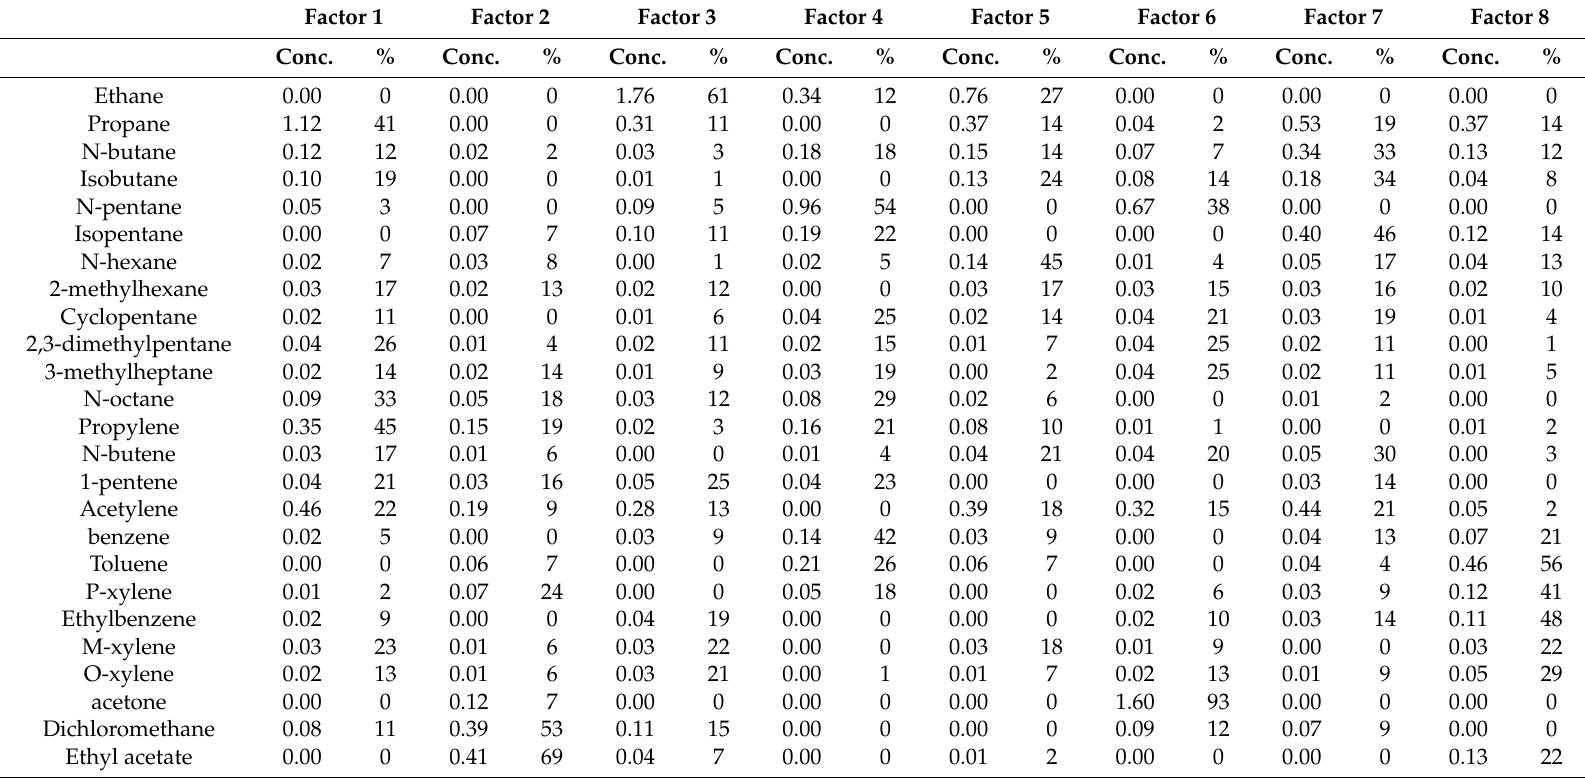
Table 2. Positive Matrix Factorization (PMF) source apportionment result. Conc. represents concentration of each compound. Percentage represents the contribution of each compound in the total amount of each